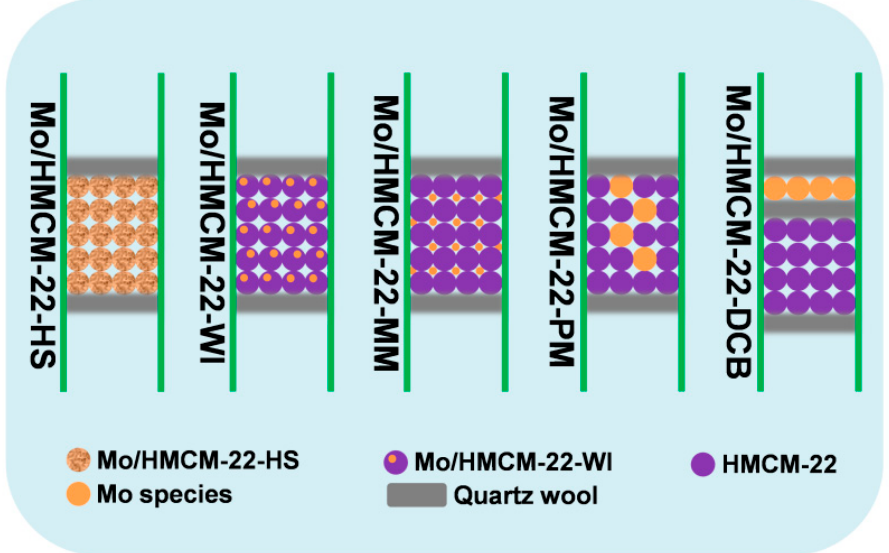
Figure 1. Schematic diagrams of the Mo/HMCM-22 catalysts with different spatial distances of Mo species and HMCM-22 zeolite. The diagrams from left to right: Mo/HMCM-22-HS, Mo/HMCM- 22-WI, Mo/HMCM-22-MM, Mo/HMCM-22-PM, and Mo/HMCM-22-DCB. These abbreviations correspond to hydrothermal synthesis (HS), wet impregnation (WI), mechanical milling (MM), physical mixing (PM), and dual catalytic beds (DCB),